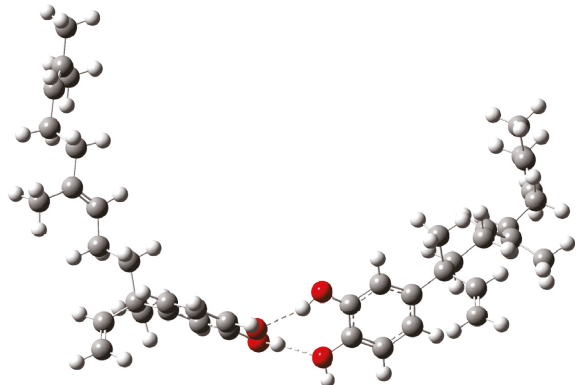
Figure 7: Proposed dimer for